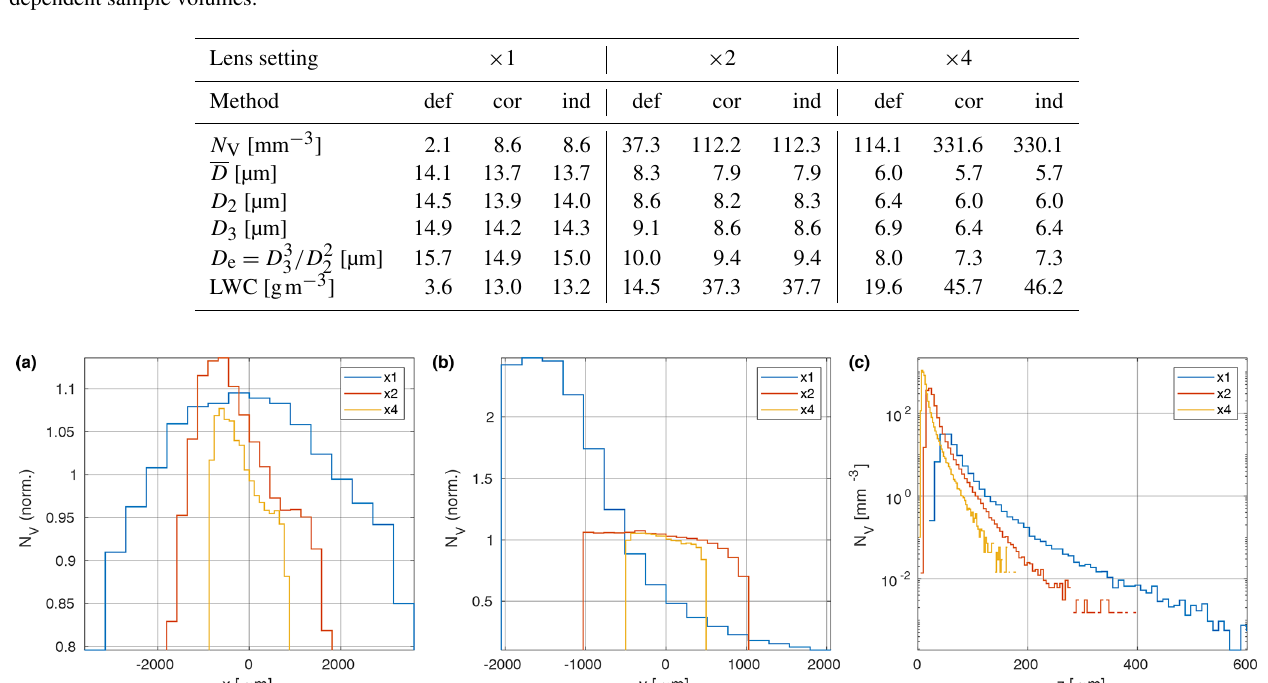
Table 4. Results of a laboratory experiment with polydisperse droplets: comparison of different methods that are used to estimate size- dependent sample volumes.